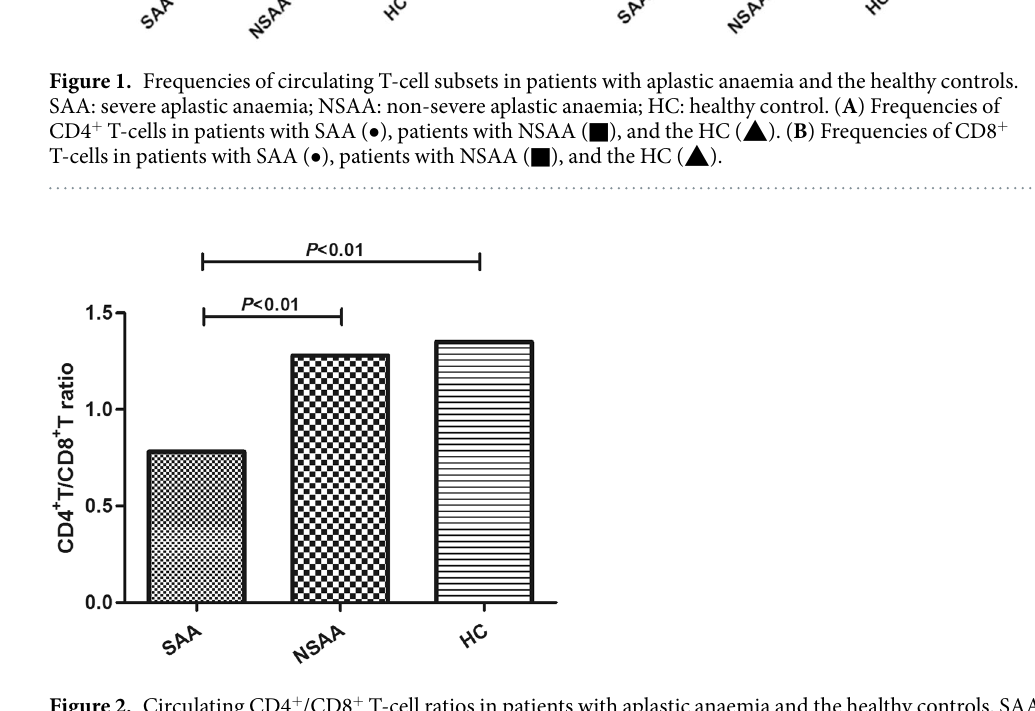
Results Frequencies of circulating T-cell subsets in patients with AA and healthy controls.